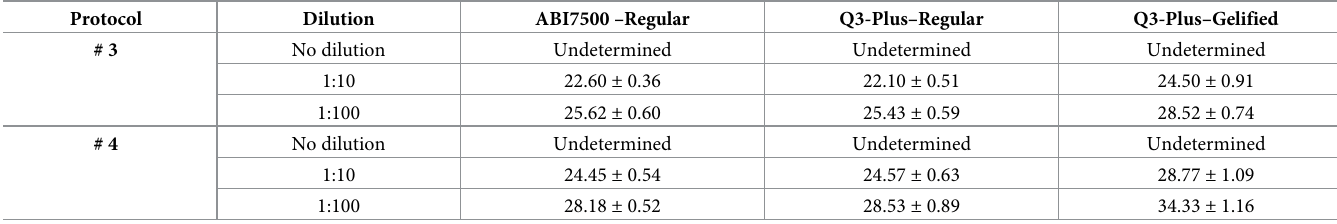
Table 4. Comparison of ABI7500 and Q3 using protocols #3 and #4. Protocol